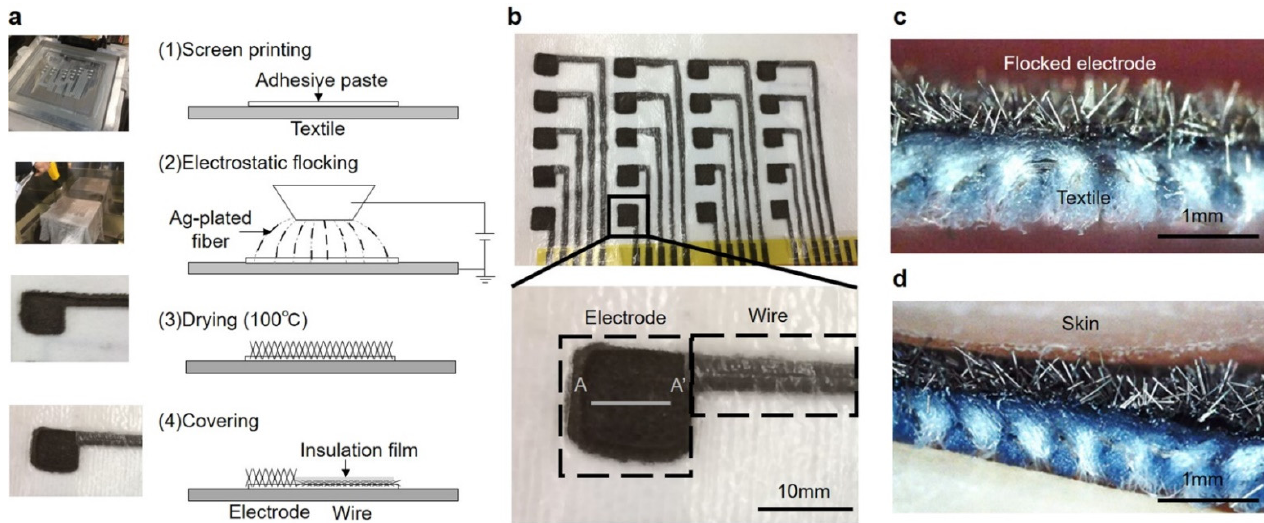
Figure 2. Production of flocked electrodes and wires with the electrostatic flocking technology. ( a ) Scheme of the production, with Ag-plated fivers being flocked on the textile with an adhesive paste; ( b ) photograph of electrodes and wires on a textile fabric; ( c ) cross-section view along the A-A ′ line (Figure 2b) of a flocked electrode; and ( d ) flocked electrode in contact with the skin. From Reference [29], originally published under a CC-BY license.